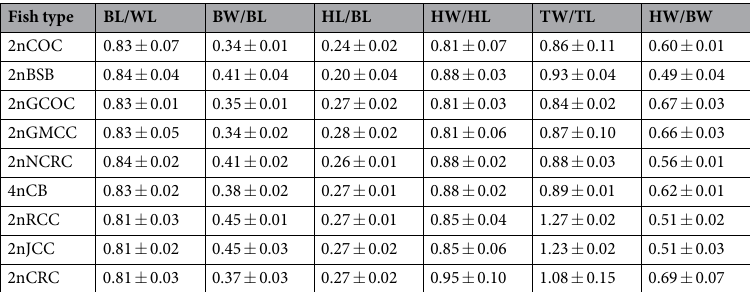
Table 4. Comparison of the measurable traits between the offspring and their parents.